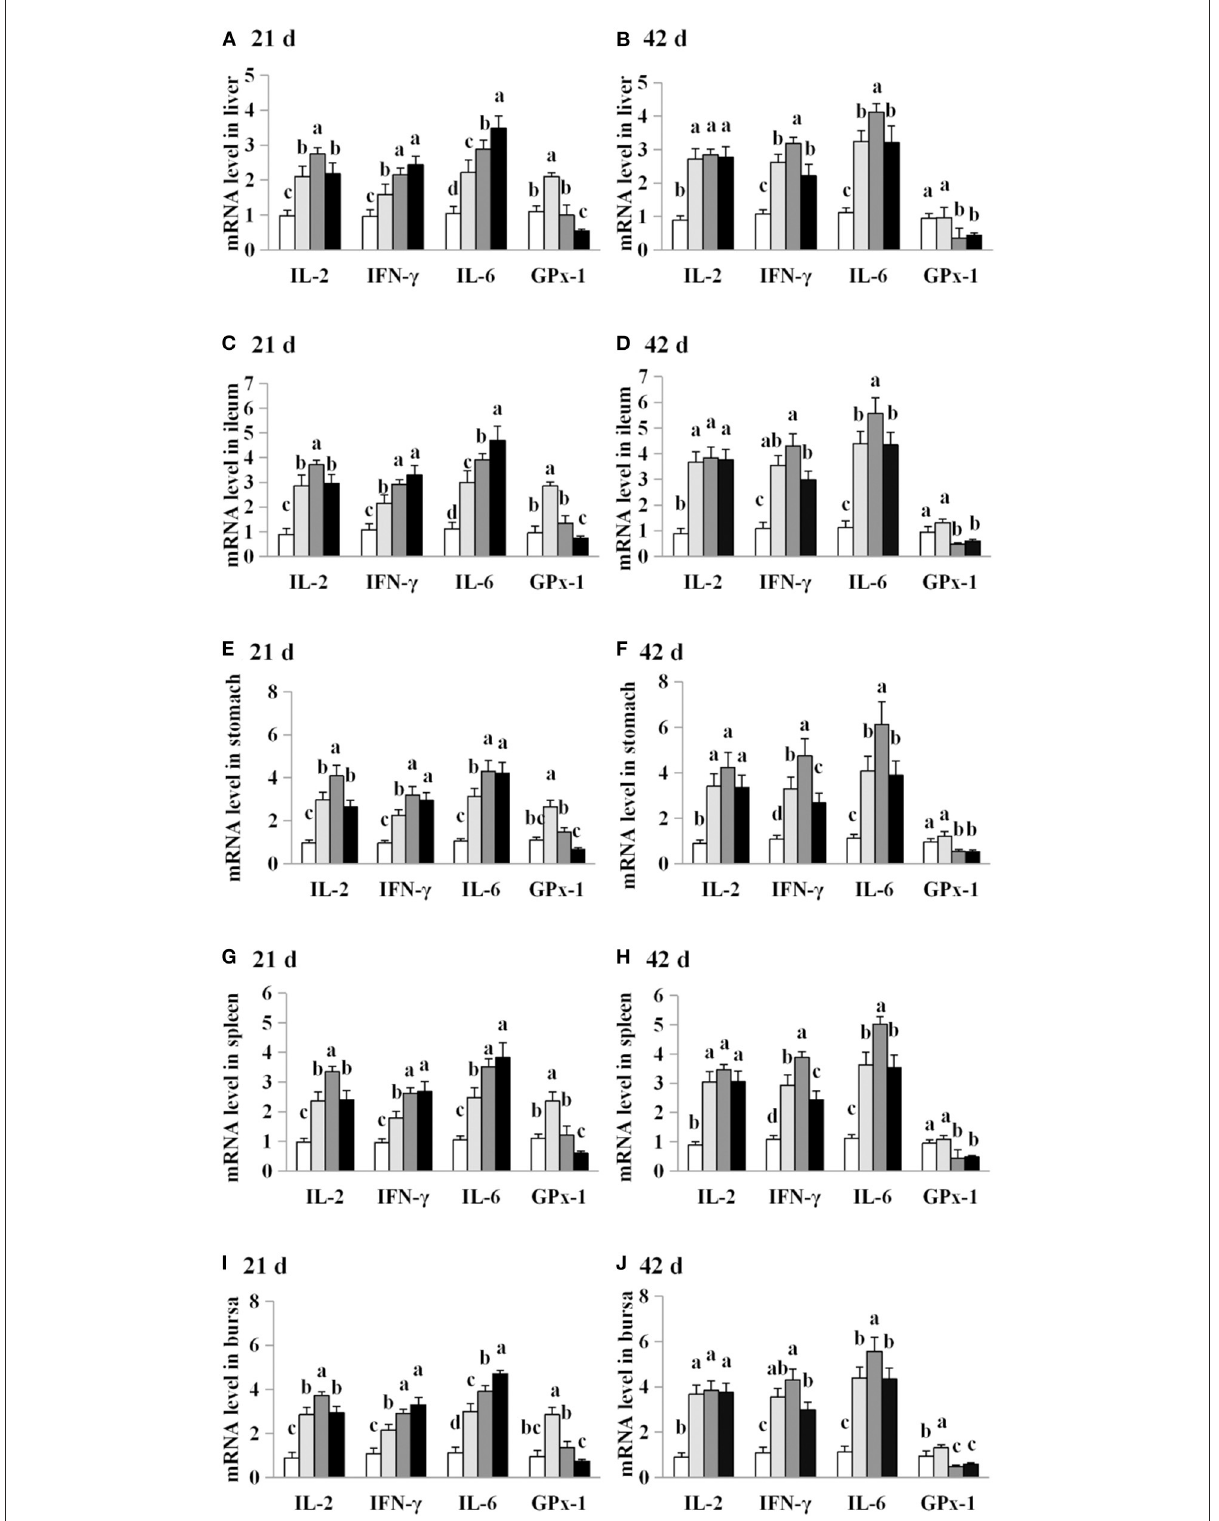
FIGURE6 Effects of AFB1 on IL-2, IL-6, IFN- γ and GPx-1 mRNA levels in the liver, spleen, ileum, stomach and bursal of chicks on day 21 and day 42. (A) IL-2, IL-6, IFN- γ and GPx-1 mRNA levels in the liver on day 21. (B) IL-2, IL-6, IFN- γ and GPx-1 mRNA levels in the liver on day 42. (C) IL-2,